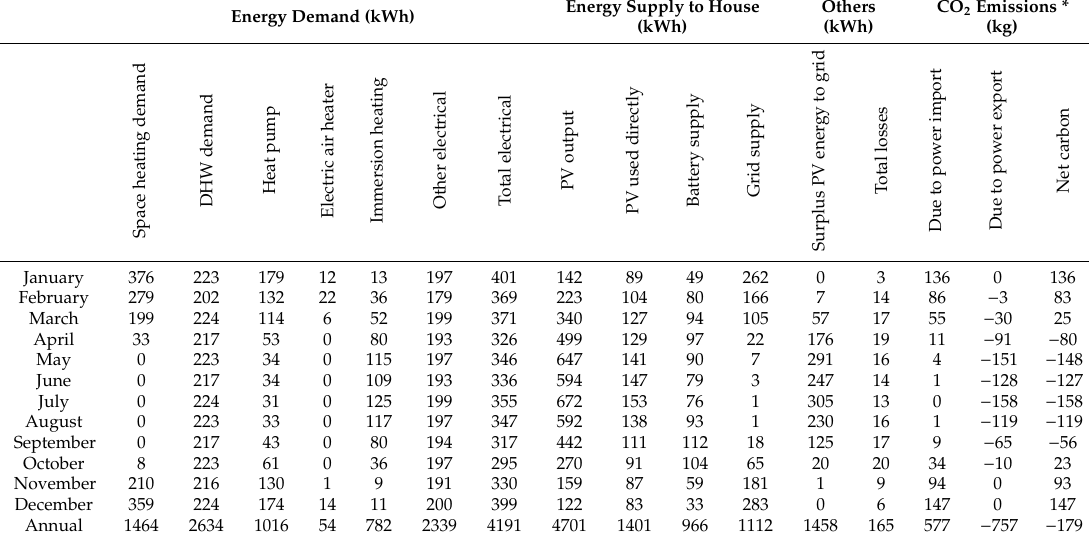
Figure 13. ( a , b ) Summer sunny week: 16 July–22 July. Table 8. Summary of monthly and annual energy demand, supply and carbon dioxide emissions. Energy Demand (kWh) Energy Supply to House